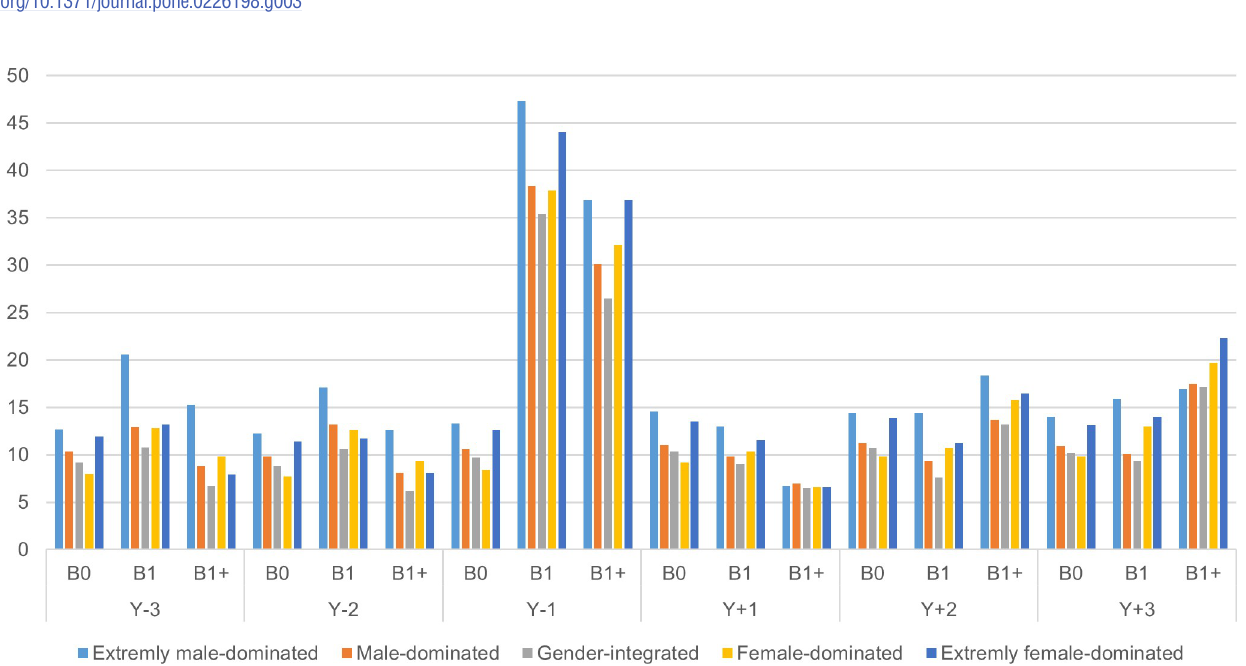
Fig 4. Proportion of women with any sickness absence spell > 14 days and/or disability pension during the six study years, by gender segregation occupational category and childbirth group. B0 indicates no childbirth before or in 2005, nor during the subsequent 3.75 years, B1 having the first childbirth in 2005 and no births during the subsequent 3.75 years and B1+ having the first childbirth in 2005 and at least one more birth during the subsequent 3.75 years.